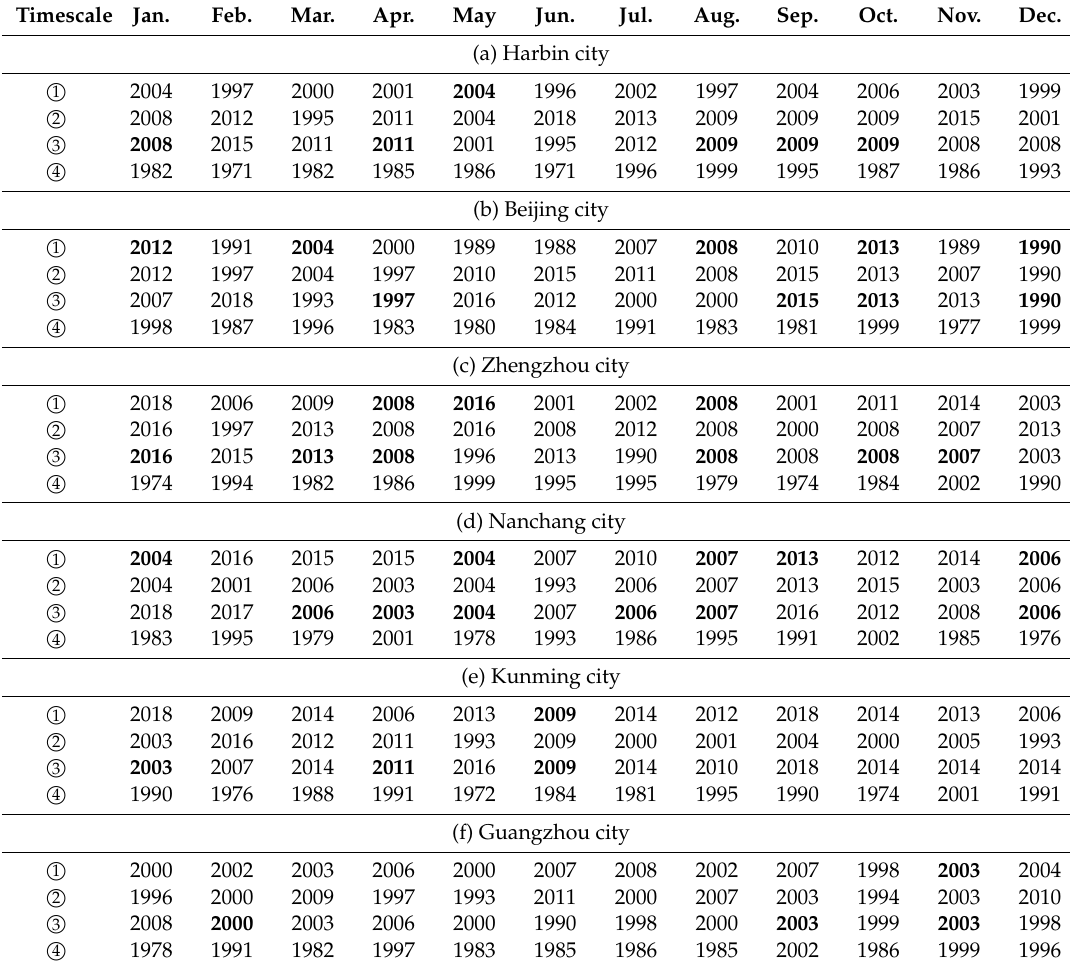
Table 1. Summary of the 12 typical meteorological months (TMMs) using di ff erent timescales for six selected cities of